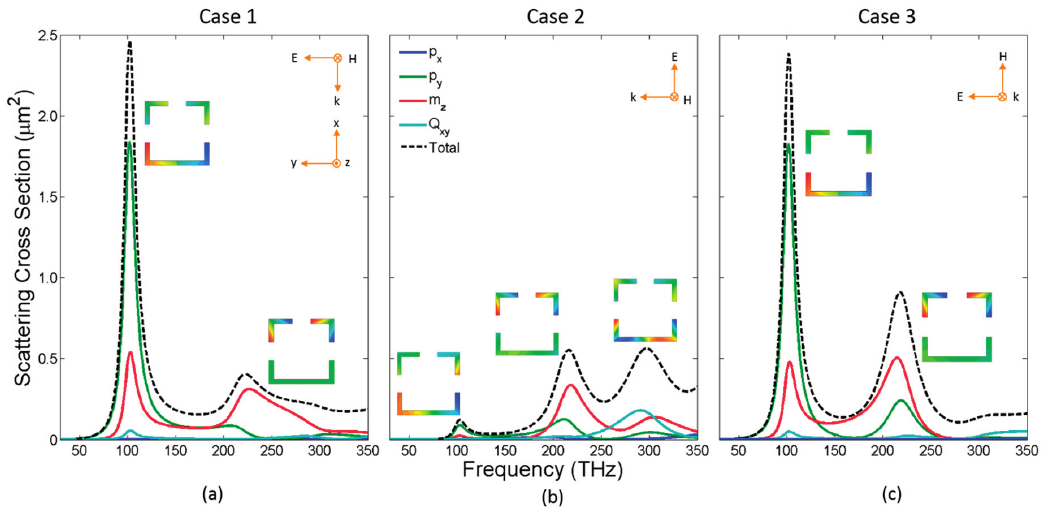
Figure 4. Multipolar decomposition of the scattering cross-section, for a 3-SRR between 30 THz and 350 THz, into the lowest order multipoles; ( a ) Case 1: electric field in-plane and along the single gap, magnetic field out-of-plane; two resonances are observed at f 1 = 121 THz and f 2 = 219 THz ( b ) Case 2: electric field in-plane and normal to the single gap, magnetic field out-of-plane; three resonances are observed, those observed in case 1 plus another one at f 3 = 297 THz ( c ) Case 3: electric and magnetic fields in-plane, along the single gap and normal to it, respectively; two resonances are observed, just as in case 1. The resonances excited in Case 1 and 3 yield both an electric dipole, (cid:1868) dipole, (cid:1865) , response similar to the 1-SRR. Insets show the real part of (cid:1831) (cid:3053) corresponding resonance frequencies using a rainbow colormap (min in blue, zero in green, and max in